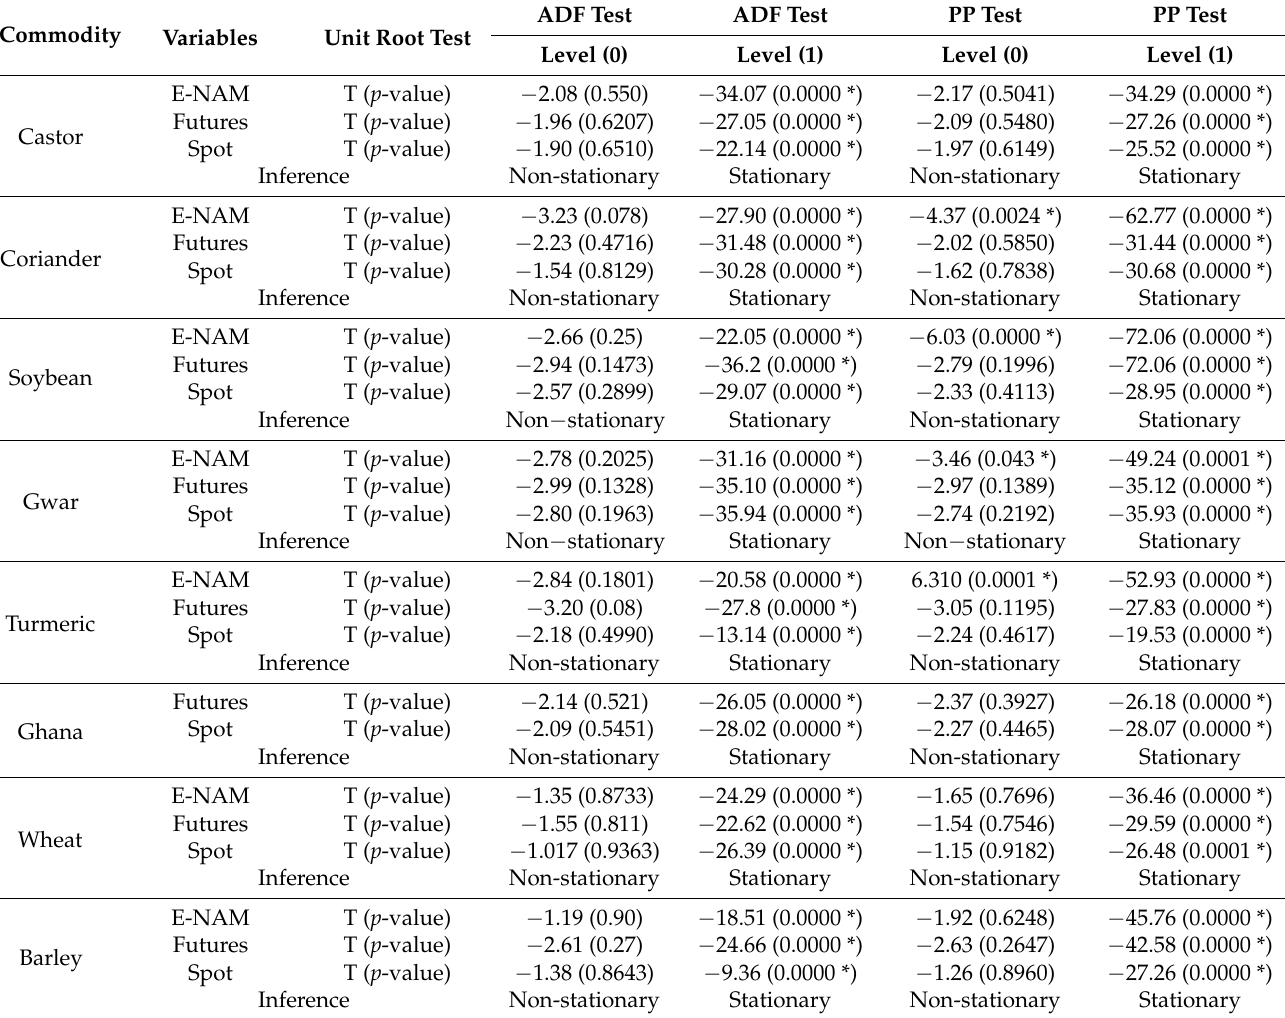
Table 1. Result of Unit Root Test for all the selected